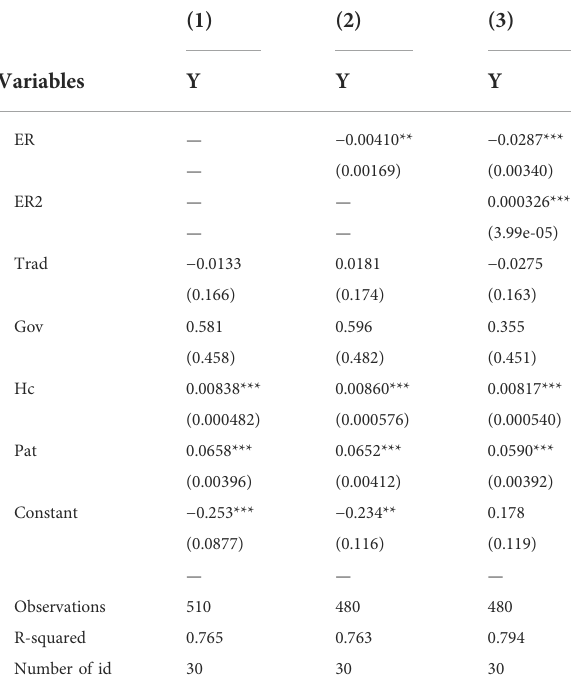
TABLE 4 Regression Results of Model (1). TABLE 5 Regression Results of Model